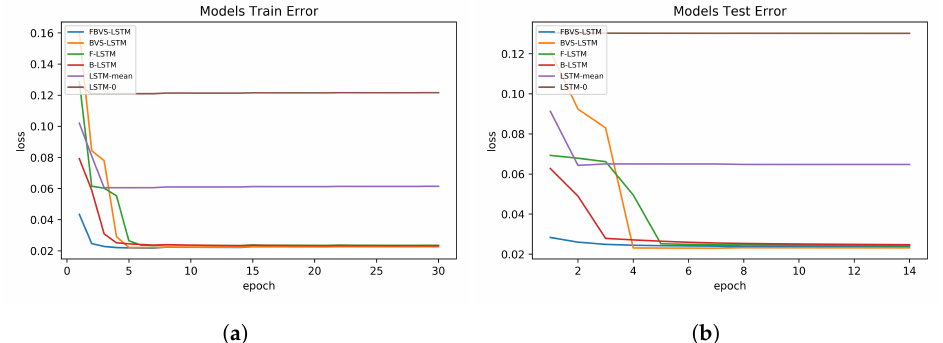
Figure 7. Models performance in Italy Air Quality dataset. ( a )Training set errors; ( b ) Test set errors.